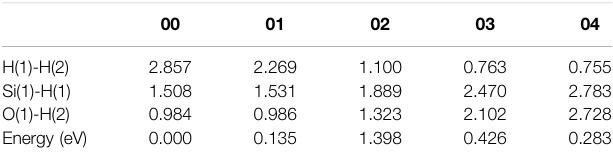
TABLE 2 | H-H, Si-H and O-H bond lengths, and the energies of the states in P b depassivation reaction. 00 01 02 03 04